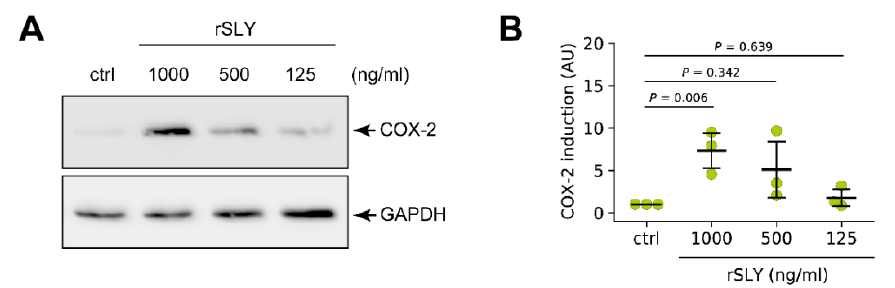
Figure 7. SLY is sufficient for COX-2 induction in porcine lung tissue. PCLS were left unstimulated or stimulated with 1000, 500 and 125 ng/mL recombinant suilysin (rSLY), respectively. ( A ) COX-2 protein expression was analysed 24 h after stimulation by Western blotting. GAPDH served as loading control. One representative of three independent experiments is shown. ( B ) Densitometric analysis of COX-2 induction in the Western blot experiments shown in ( A ). Data are presented as mean ± SD of three independent experiments. Exact p values are indicated (Welch ANOVA followed by Games–Howell post hoc test).